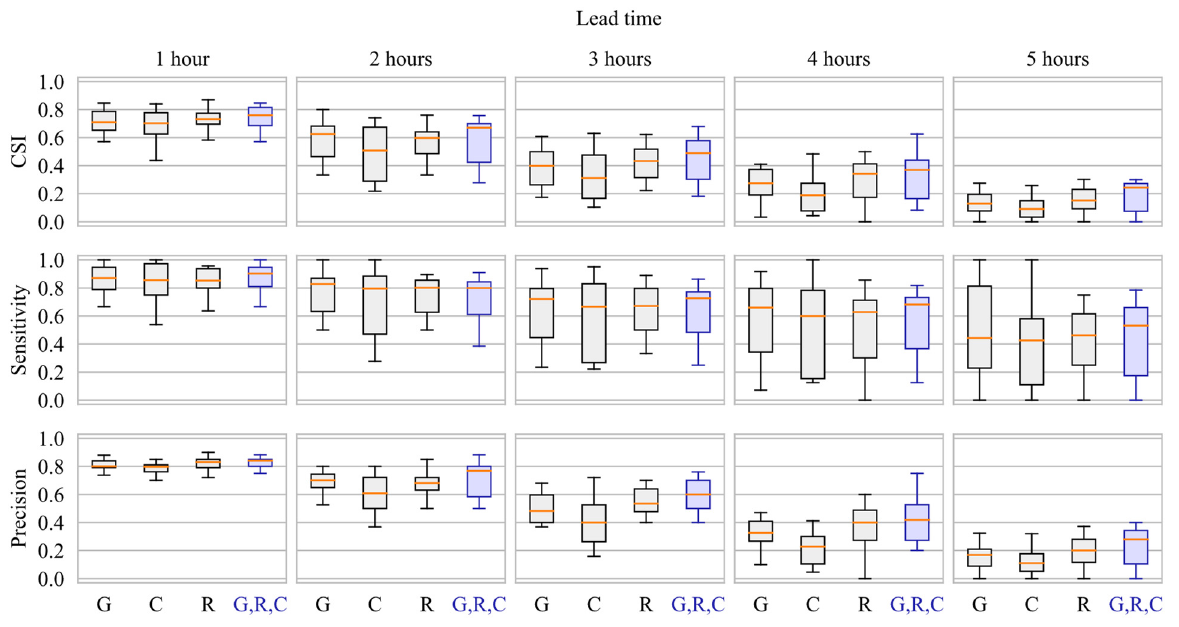
Figure 11. Contingency analysis on predicting high-flow events for the ML models using only QPEs from gauge (G), only from ground-based weather radar (R), only from CaPA as representative of NWM (C), and using all of them (G,R,C). Table 5. Summary of mean performance gains—metrics related to contingency analysis. Best Single QPE 3 QPEs Metric Lead Time ( 𝐡 ) QPE Value